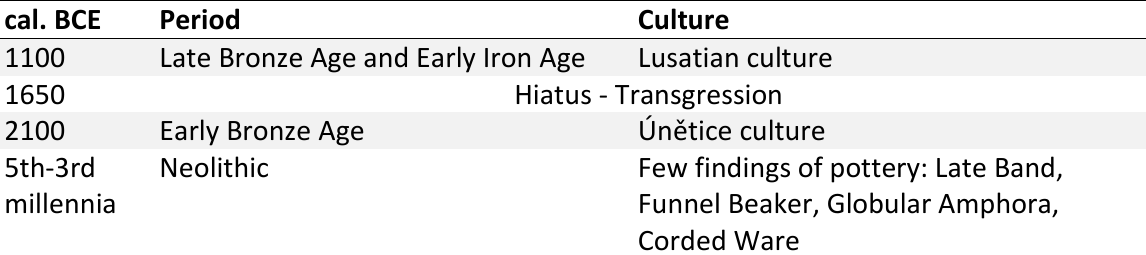
Table 1. Chronological sequence of Bruszczewo. cal.